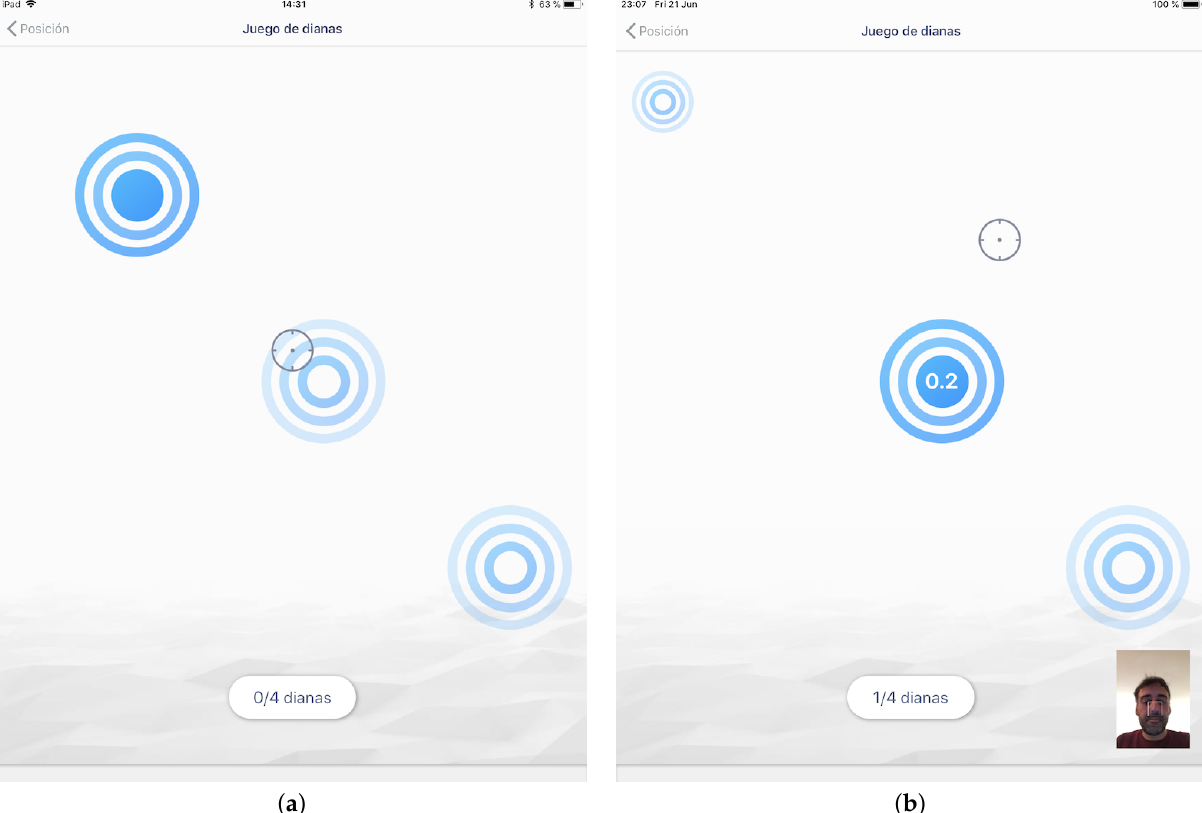
Figure 8. Screenshots of the dart game with two dwell-time criterion: ( a ) 0-ms dwell-time criterion: the target was selected immediately when the center of the cursor entered inside the target, and ( b ) 200-ms dwell-time